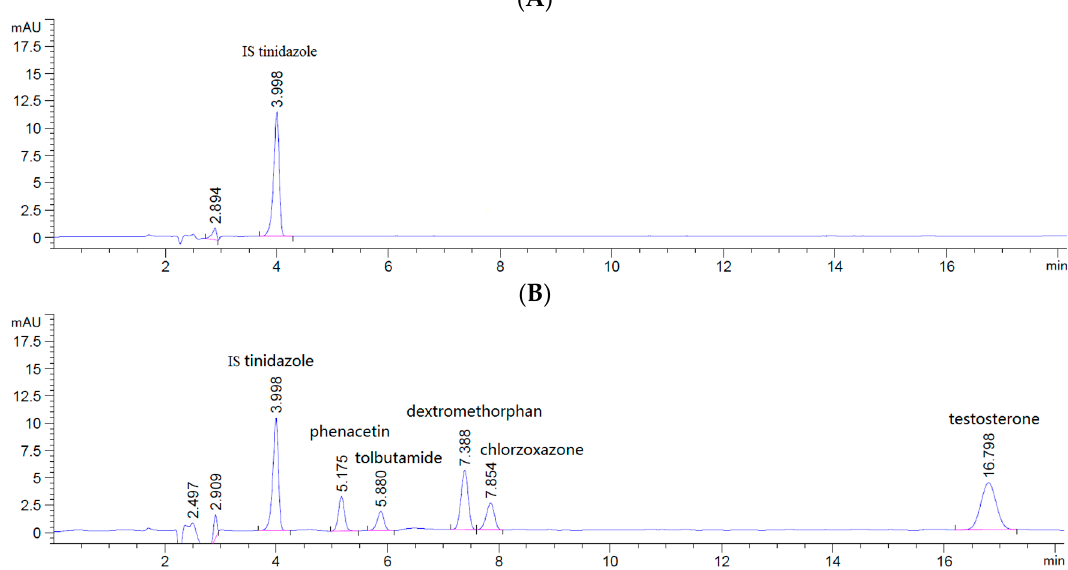
Figure 9. Chromatograms of five cocktail probe drugs and tinidazole (IS) in the incubation system. IS in blank sample ( A ); sample spiked with five cocktail probe drugs and IS ( B ). Table 2. Regression equation, linear range, and LLOQ for the probe substrates used in incubations.